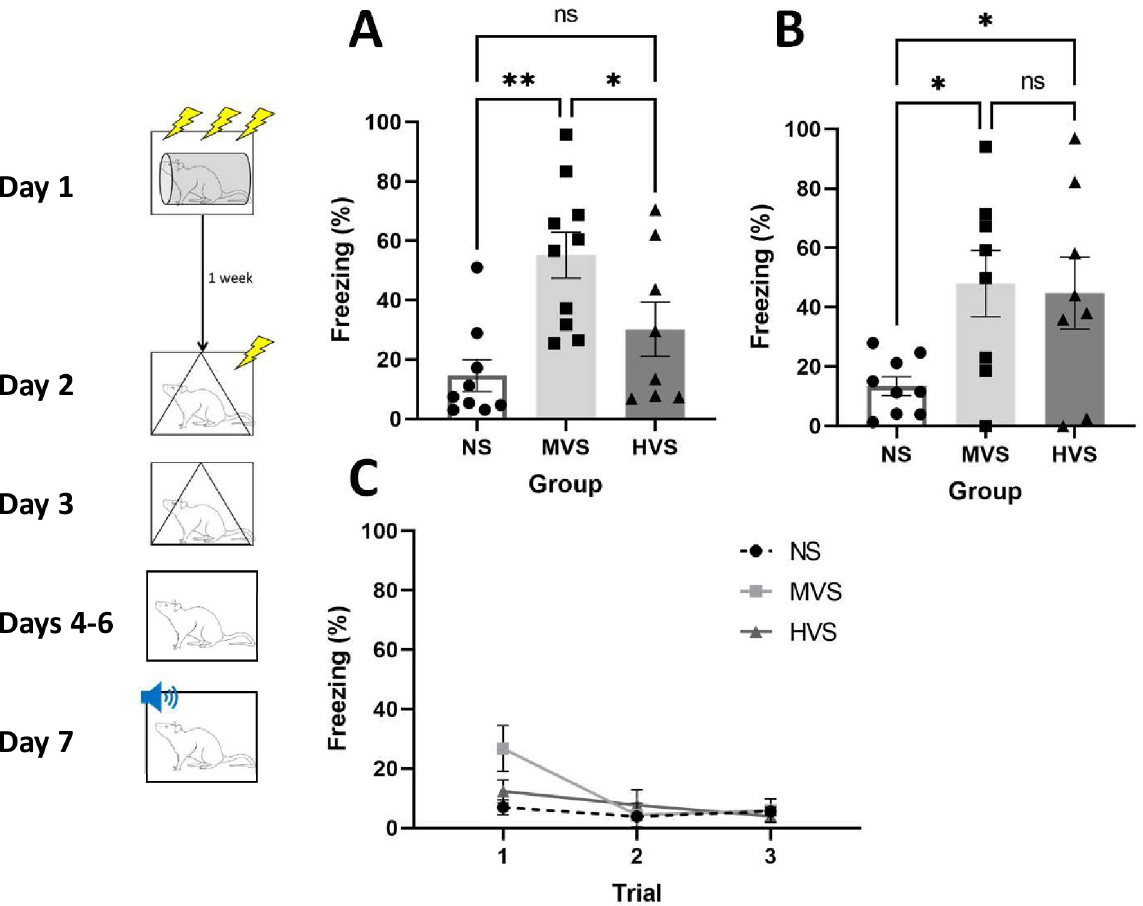
Fig 2. Moderate and HVS exposure results in enhanced cued fear conditioning. Depicted: Percent freezing during context conditioning test (panel A), presentation of the conditioned tone (panel B), and the first eight minutes of each context preexposure trial (panel C). Rats were exposed to 0 (NS), 15 (MVS), or 100 (HVS) tailshocks one week prior to single-trial fear conditioning. Testing consisted of exposure to a single, 1 mA shock in a novel context following presentation of a 30-second tone. Rats were then returned to this same context 24-hours later. Rats were then pre-exposed to another novel context. In this context, the previously-conditioned tone was presented and freezing was assessed. The MVS group spent more time freezing during the context test when compared to NS and HVS groups. Interestingly, both MVS and HVS groups showed higher levels of freezing to the tone compared to the NS group. Error bars denote mean ± SEM. � p < .05, �� p <